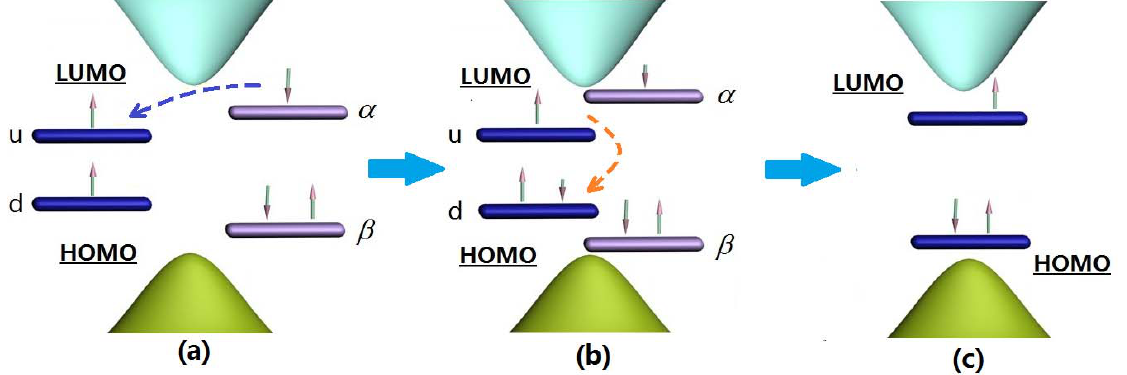
3. Schematic diagram of the electron population during the electronic two-transition process.